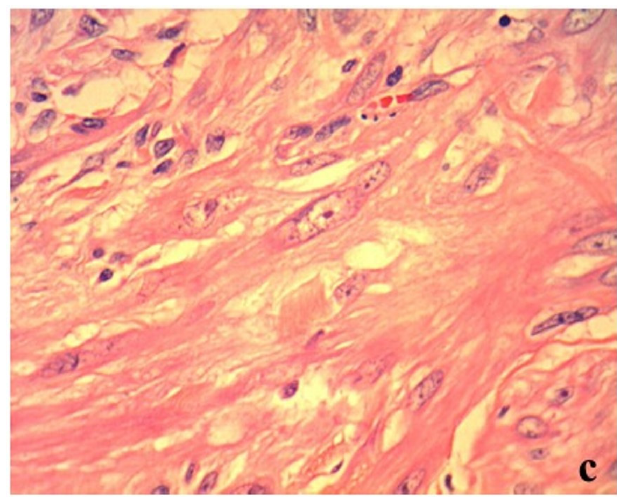
Figure 2. Macroscopic and histopathological findings of the surgically resected mass. ( a ) Macroscopic findings: The mass protruded from the serosal surface of the jejunum. ( b ) Histopathological findings (low-power field): The mass was located in the extraluminal space of the intestinal tract, but there was no transmural invasion of the tumor in the mucosa. No intestinal bleeding was detected, and lymphatic vessels on the mucosal surface were expanded. ( c ) Histopathological findings (high-power field): The mass revealed a mild atypical monomorphic proliferation of non-epithelial cells, exhibiting a spindle shape with abundant eosinophilic cytoplasm and resembling a smooth muscle. Tumor cells were classified as malignant based on anisonucleosis, the increased nuclear–cytoplasmic ratio, and the presence of prominent nucleoli.